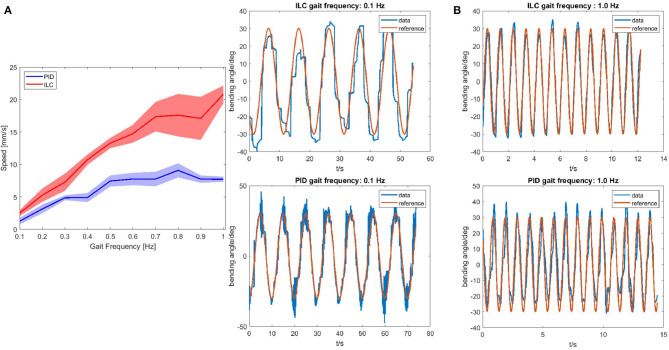
(A) Relationship between gait frequency and speed of 2D soft robotic snake under ILC and PID controller. Shade shows the standard deviation of the result. (B) Bending angle and reference for one of the four modules on the snake controlled with ILC controller and PID controller tracking sinusoidal waves under the gait frequency of 0.1 and 1.0 Hz.